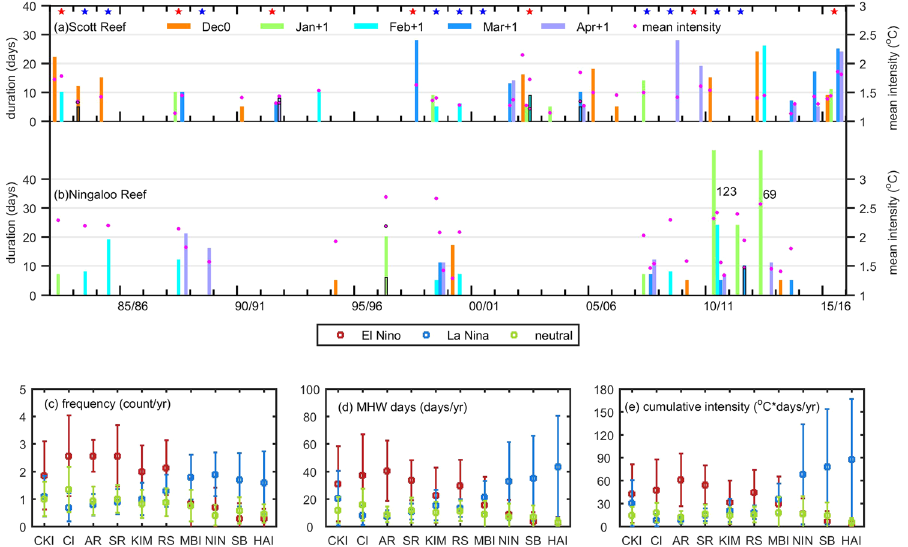
Figure 3. ( a , b ) Duration (bars) and mean intensity (dots) of MHW events peaking in extended summer months (December-April) at the Scott and Ningaloo reefs, respectively. The time axis corresponds to the peak month of each MHW event. The red (blue) stars denote the developing years of El Niño (La Niña). ( c – g ) Composited characteristics of MHW events at the 10 reefs in the extended summer months (December-April) of El Niño and La Niña events. The error bars denote 95% confidence intervals. Figures are plotted using MATLAB R2015b